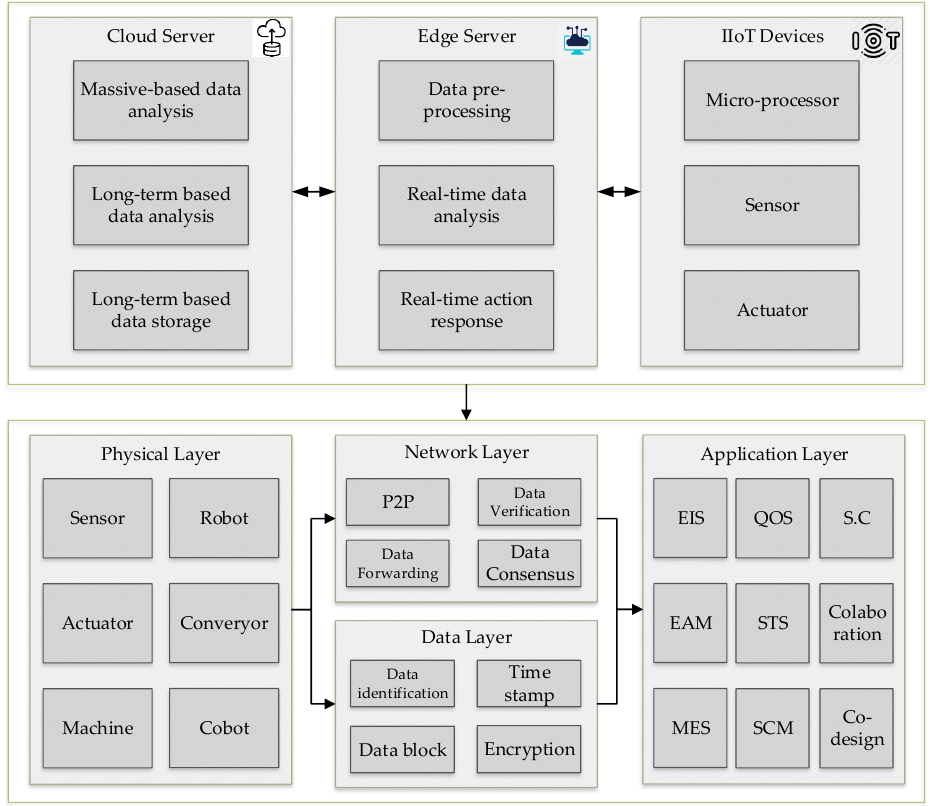
Figure 2. Overview of edge computing